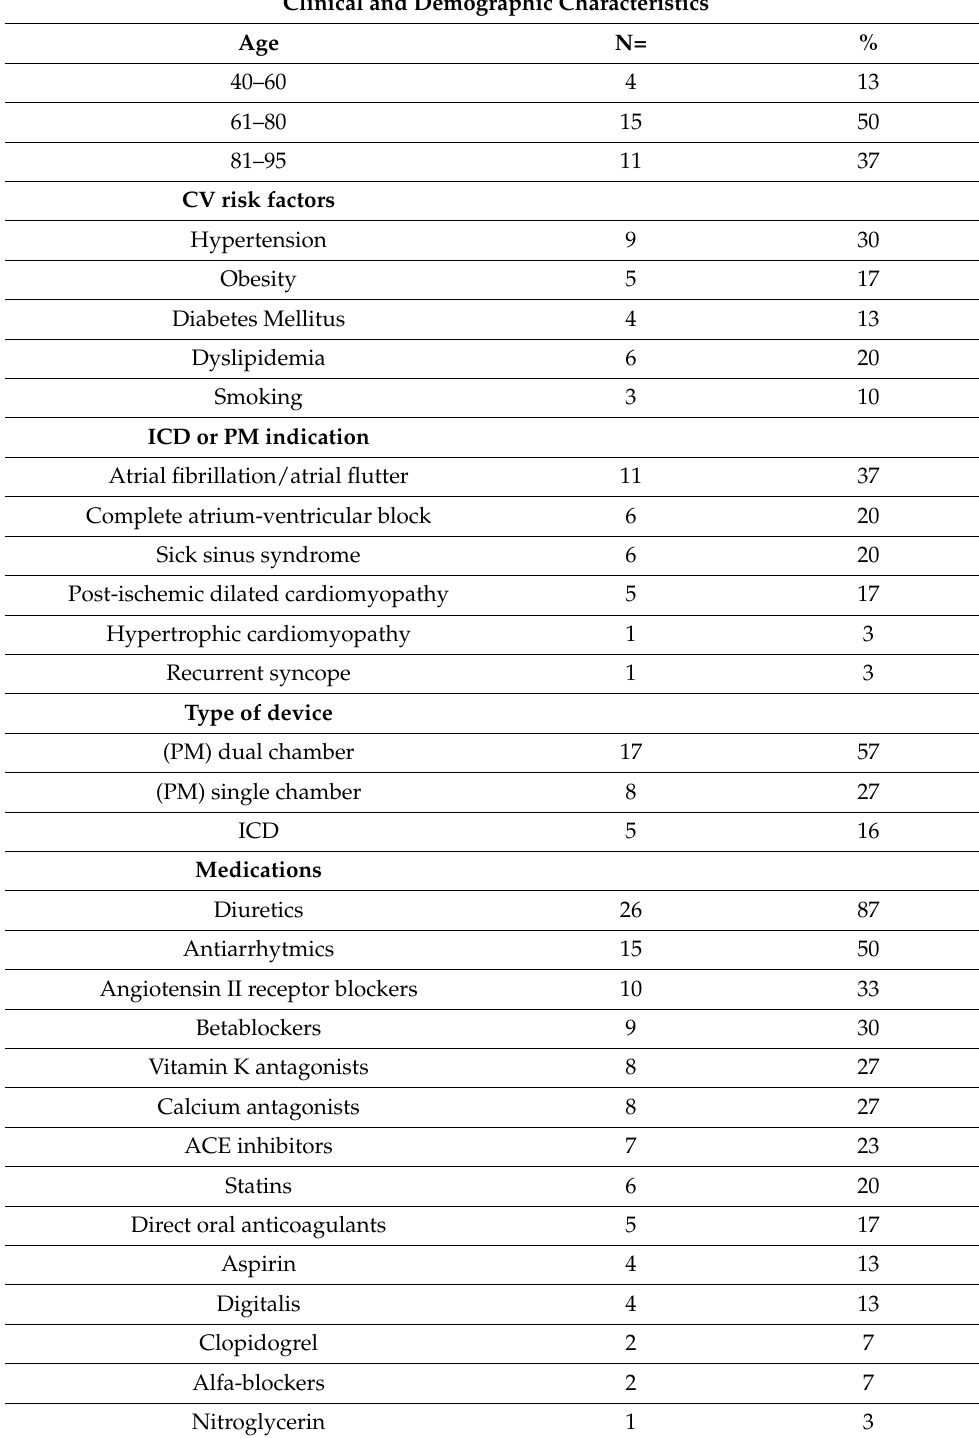
Table 1. Clinical and demographic characteristics of patients with implantable cardiac